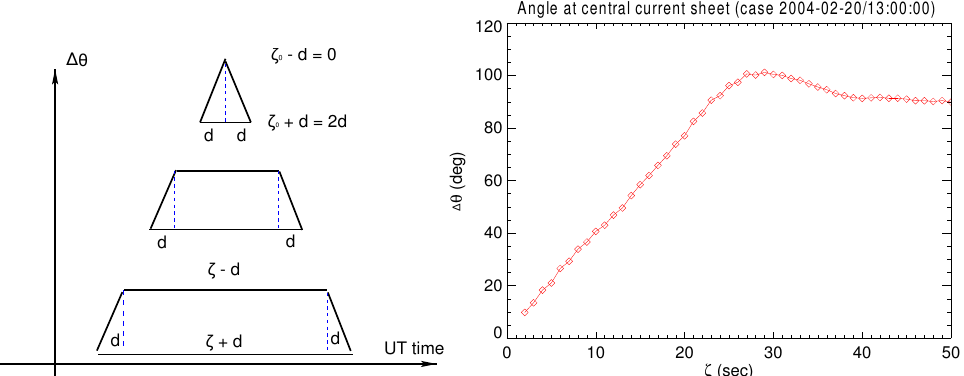
Fig. 4. Figure showing how d and 1θ are obtained. The left panel shows how the shape of 1θ(ζ,t) varies with ζ . 1θ(ζ,t) s for three ζ s are shown. The bottom part corresponds to the largest ζ , which is taken to be larger than the width of the current sheet, d . The shape of 1θ as a function of time is an isosceles trapezoid. The top side has a length of ζ − d and the bottom side has a length of ζ + d . As ζ decreases, this isosceles trapezoid gets compressed, until a critical value of ζ 0 = d is reached, in which case, the isosceles trapezoid becomes an isosceles triangle. The right panel is an actual case showing the deflection angle 1θ(ζ,t 0 ) as a function of ζ . Here t 0 is at the center of current sheet. As ζ increases from zero, the deflection increases linearly at the beginning, reflecting the fact that the current sheet has a finite width and the direction of magnetic field within the current sheet changes gradually inside the current sheet. At large ζ s, 1θ reaches a plateau, signaling the fact that ζ is now bigger than d